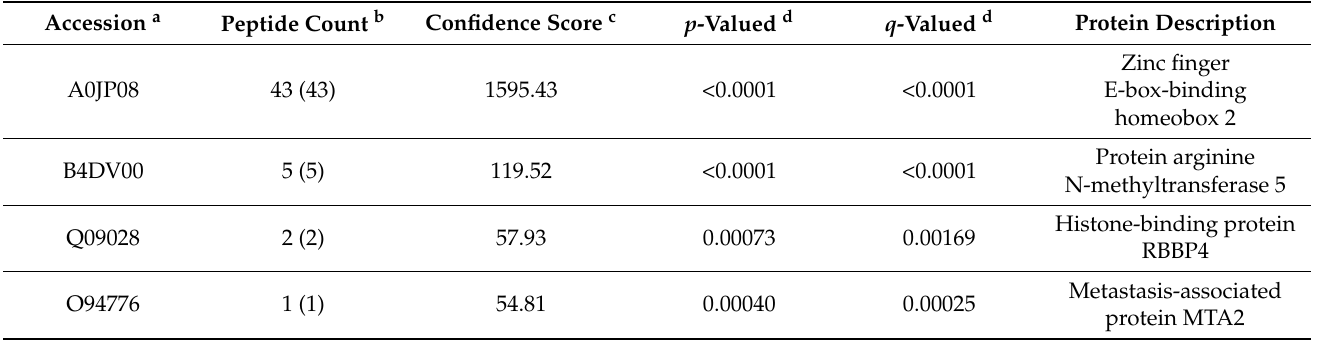
Table 1. Identification and LC–MS based label free quantification of the binding partners of ZEB2 following HA affinity